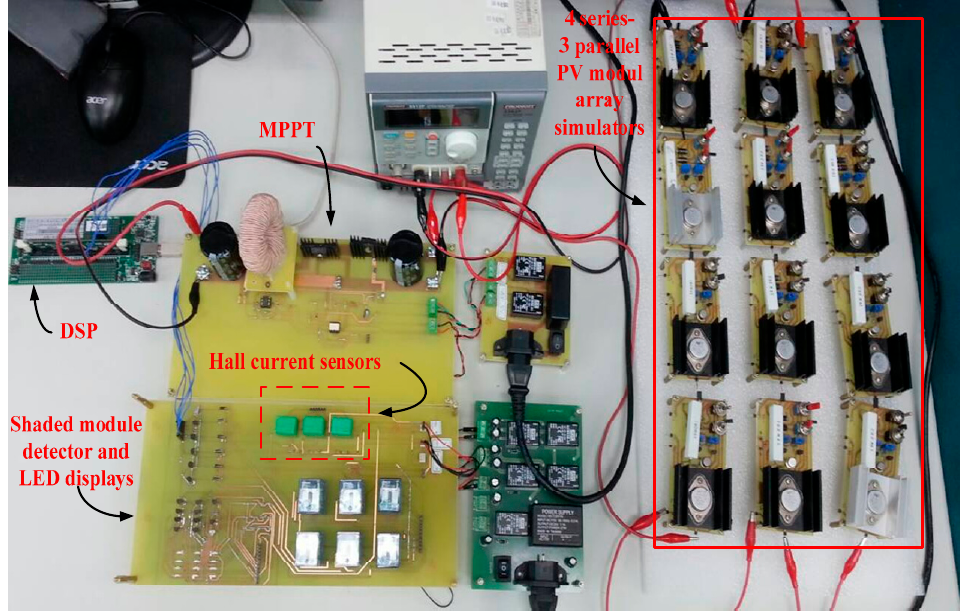
Figure 11. A photo of the implemented online fault diagnosis system.